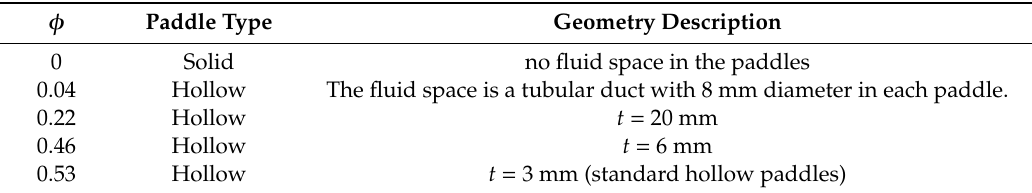
Table 1. Hollow paddles with di ff erent φ ( m = 2, H = 62 mm, d = 8 mm).